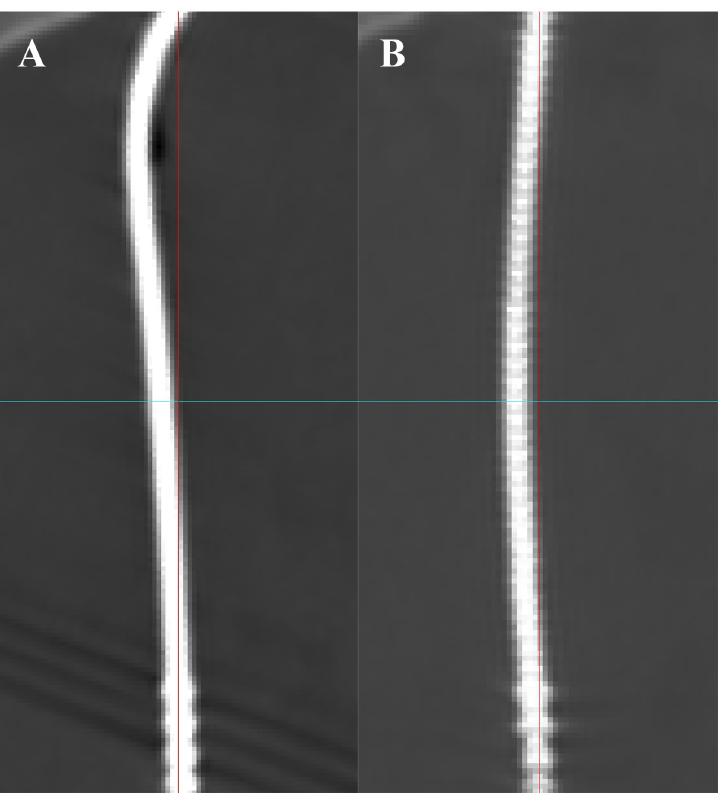
Fig 6. Change of lead shapes over time. These figures demonstrate how the lead shapes change over time. A lead that was bent on the day of operation (A) became straightened after 24 months (B).